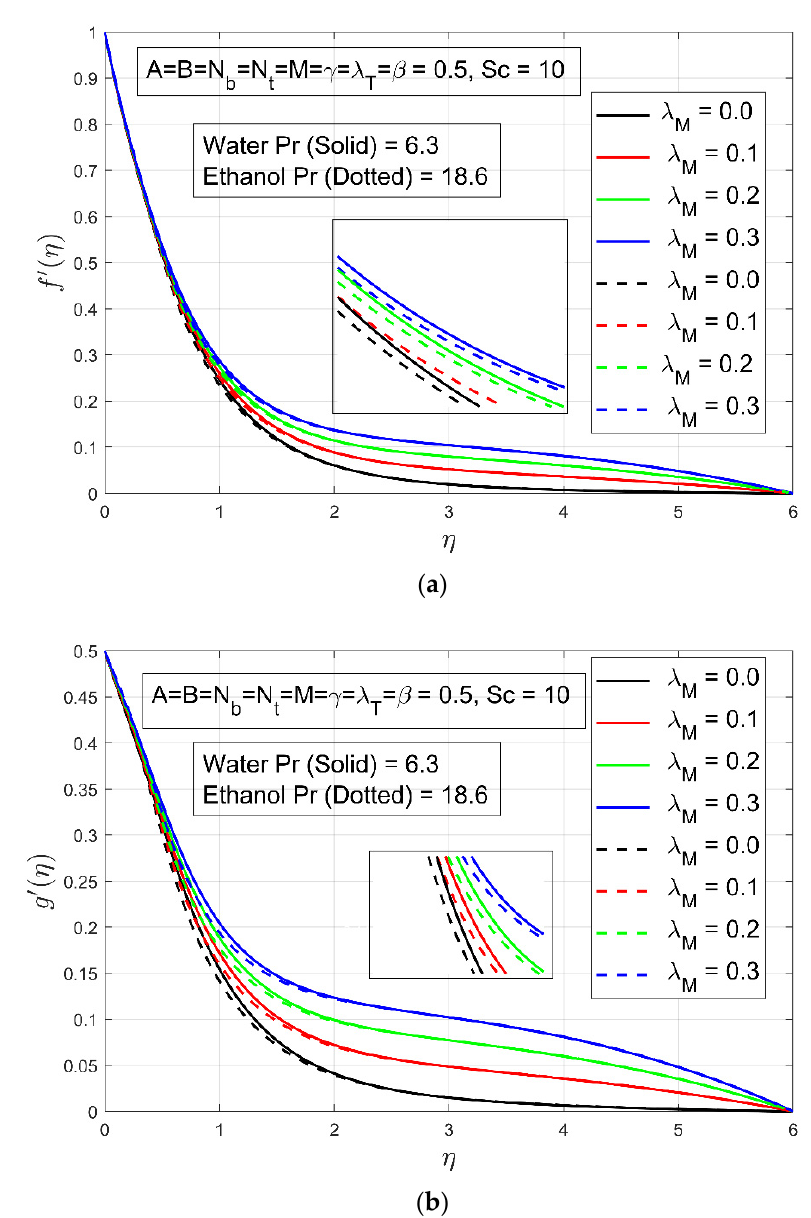
Figure 4. ( a ) The effect of λ M on velocity profile f (cid:48) ( η ) ; ( b ) The effect of λ M on velocity profile g (cid:48) ( η ) .